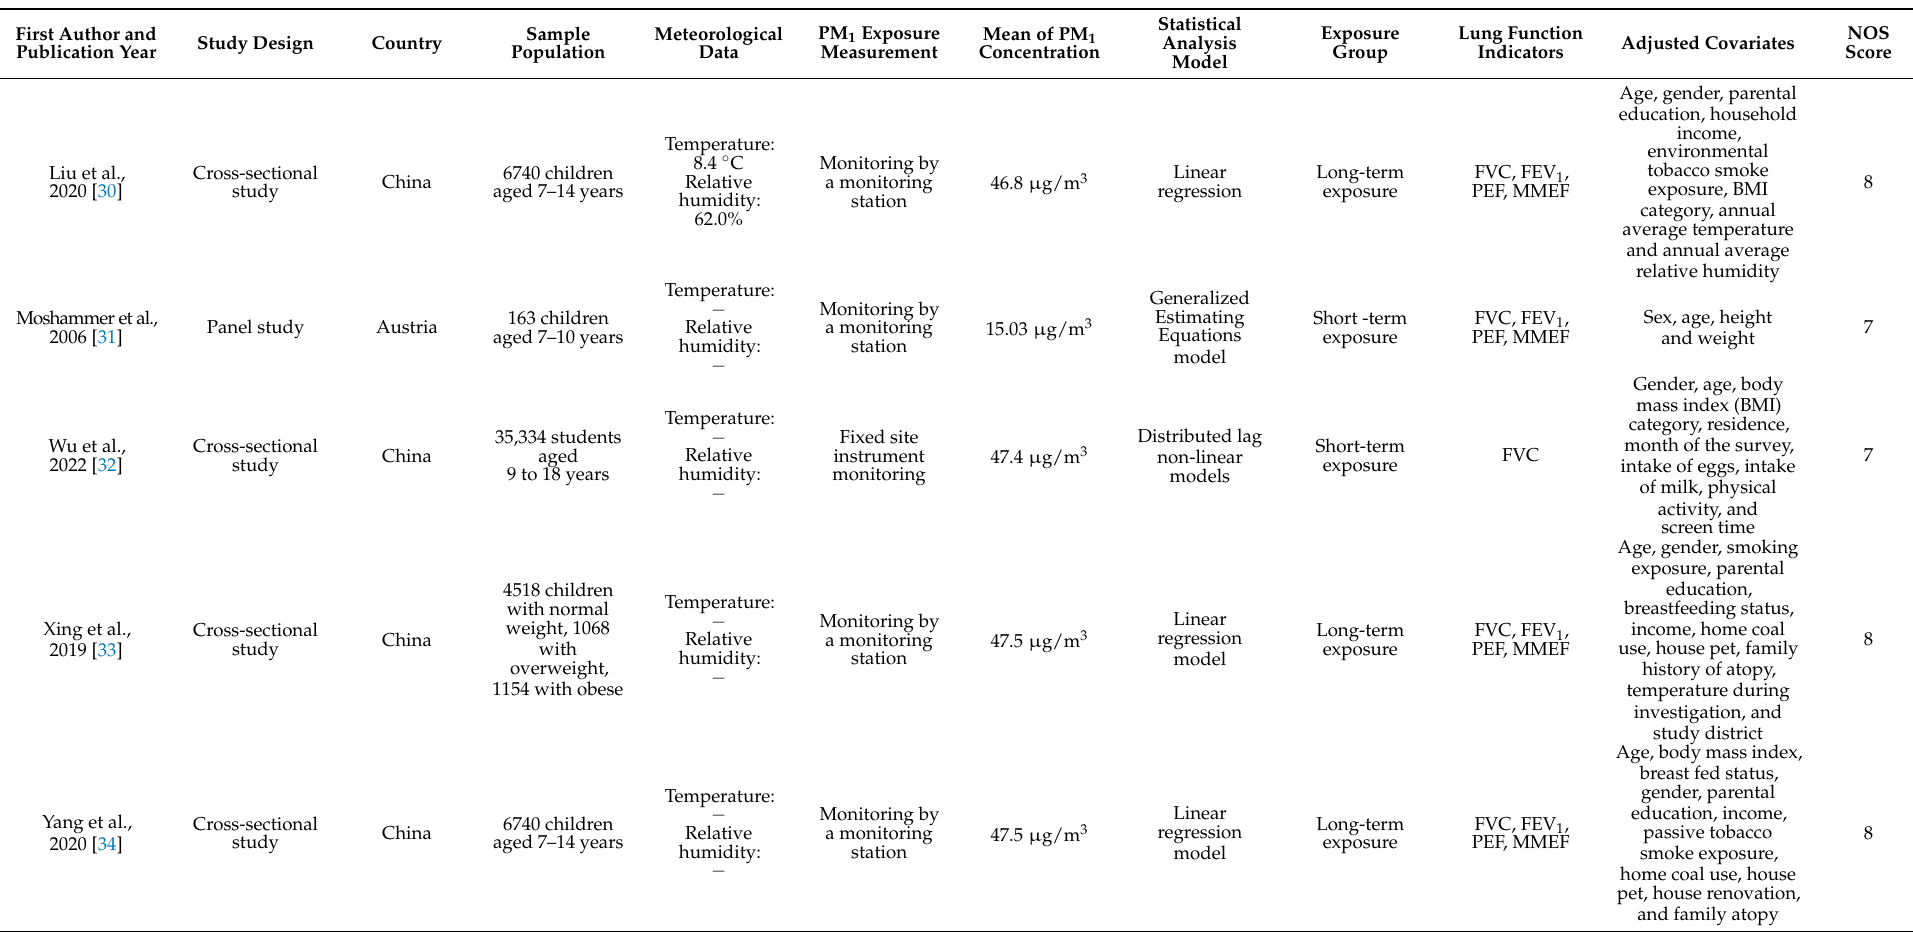
Table 1. Basic characteristics of the studies included in the